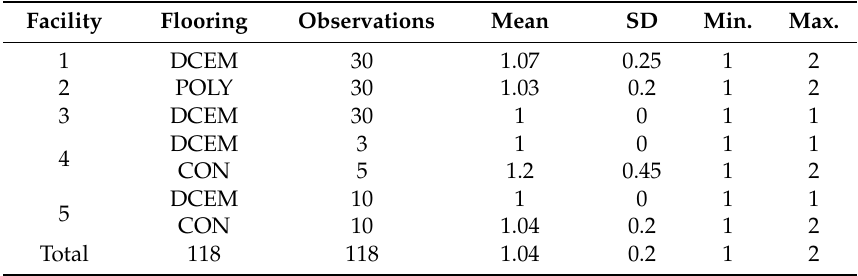
Table 5. Visual Body Cleanliness Scores (BCLS). Summary of the results of the cleanliness scoring by facility and floor type. DCEM: Diamond-shaped coated expanded metal; POLY: Polypropylene; and CON: Concrete.